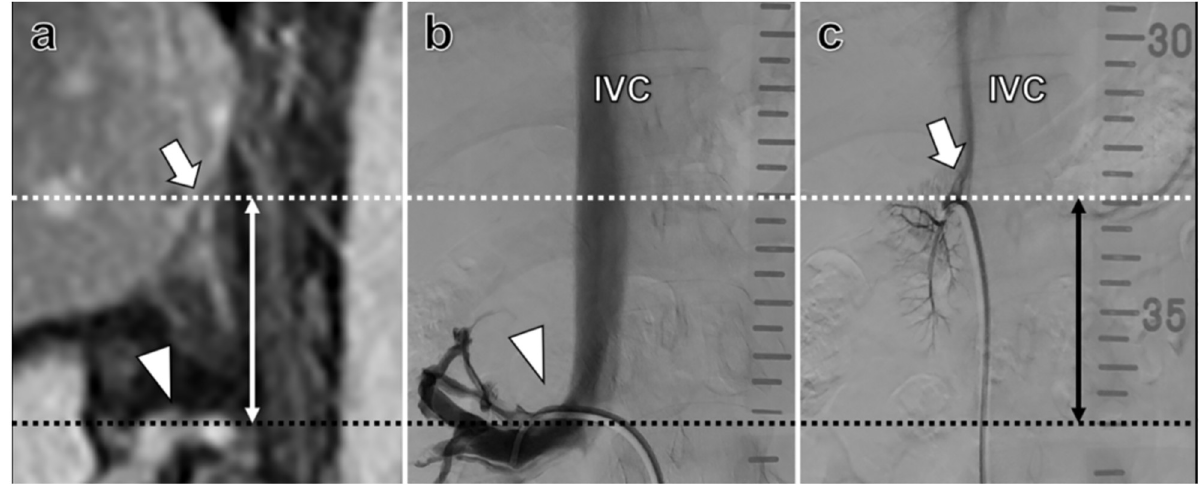
Fig 1. Estimation of pre- and peri-interventional right renal vein to right adrenal vein (RRV-RAV) distance in a 35-year-old woman with suspected Conn syndrome. (a) Para-coronal fat-saturated T1-weighted contrast-enhanced MRI illustrates pre-interventional estimation of RRV-RAV distance. (b, c) Illustration of angiographic RRV-RAV distance estimation. During adrenal vein sampling, a radiopaque planning ruler was placed underneath each patient and aligned along the spine. The right renal vein was then probed with a 5F-C2-catheter and delineated by contrast agent injection (arrowhead) in resting end-expiratory position. Aimed cannulation of the right adrenal vein was then focused at the height of the pre- interventionally determined RRV-RAV-distance and confirmed by contrast injection (arrow). Black dotted line marks the upper border of the renal vein. White dotted line marks the level of the right adrenal gland/RAV. IVC = Inferior vena cava.